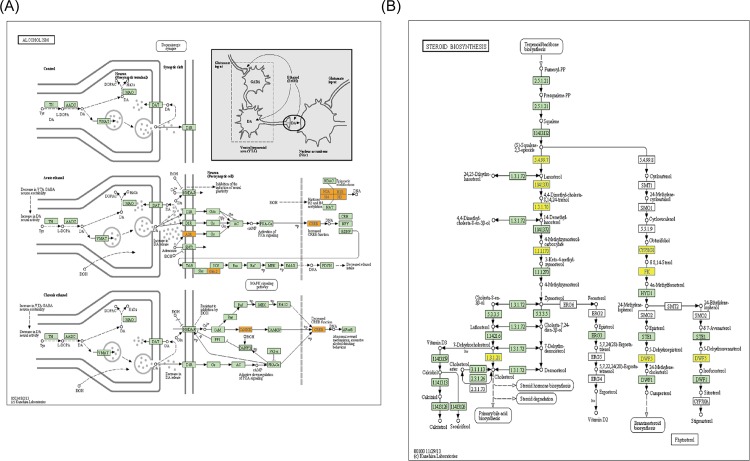
Representational pathway schematic diagrams.(A) Pathway: Alcoholism—Homo sapiens (human). (B) Pathway: Steroid biosynthesis—Homo sapiens (human).The bar plot shows the top ten Enrichment score (-log10 (P value)) value of the significant enrichment pathway. Yellow marked nodes are associated with down-regulated genes, orange marked nodes are associated with up-regulated or only whole dataset genes, green nodes have no significance.